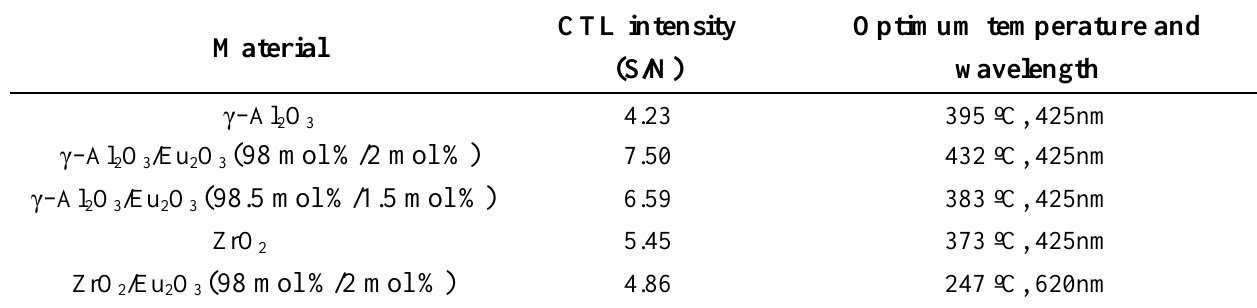
Table 1. The CTL intensities of benzene vapor on the nanosized